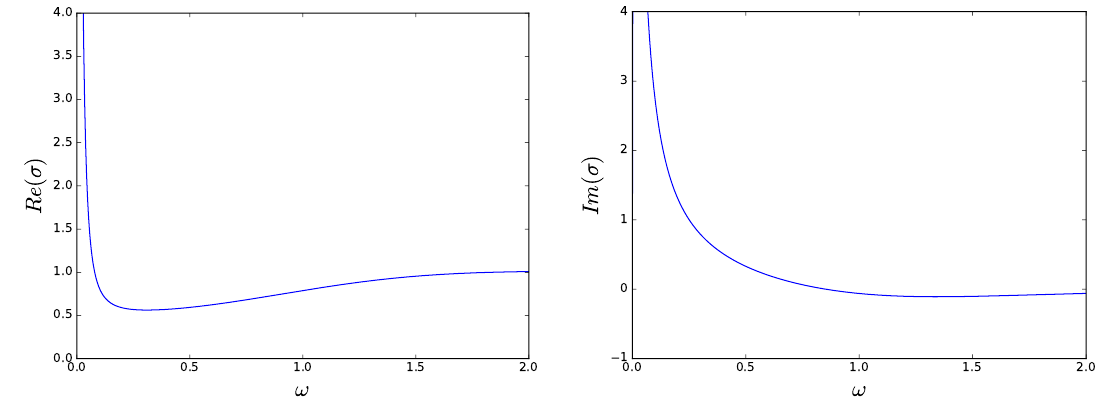
Figure 1 . The real (left) and imaginary part (right) of the optical conductivity for k = 0 : 2, T = 0 : 2, and (cid:22) = 1 :